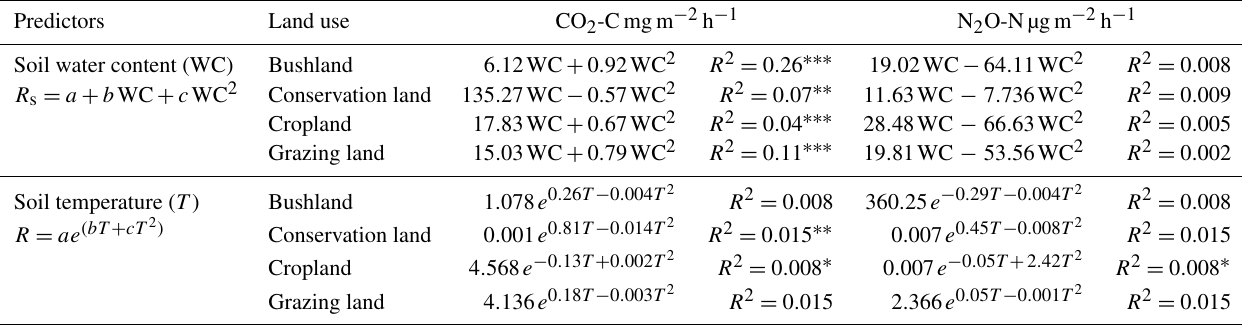
Table 2. Soil water content (WC) and soil temperature ( T ) control on carbon dioxide (CO 2 ) and nitrous oxide (N 2 O), denoted by R s ; a , b , c , and e denote the model coefficients.